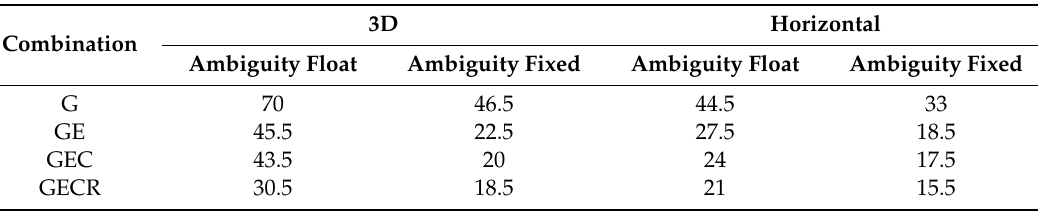
Table 3. Convergence times (min) to achieve 10 cm positioning accuracy of the 3D and horizontal component of di ff erent combinations in a 90% probability.